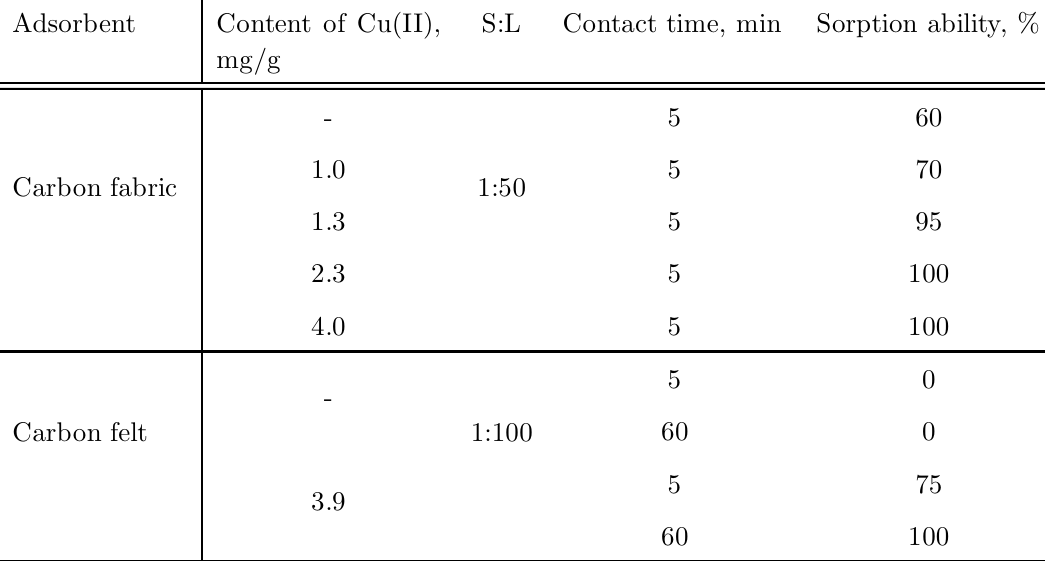
Table 2 Sorption ability of carbon materials towards cholerae vibrio (initial concentration 10000 microbe